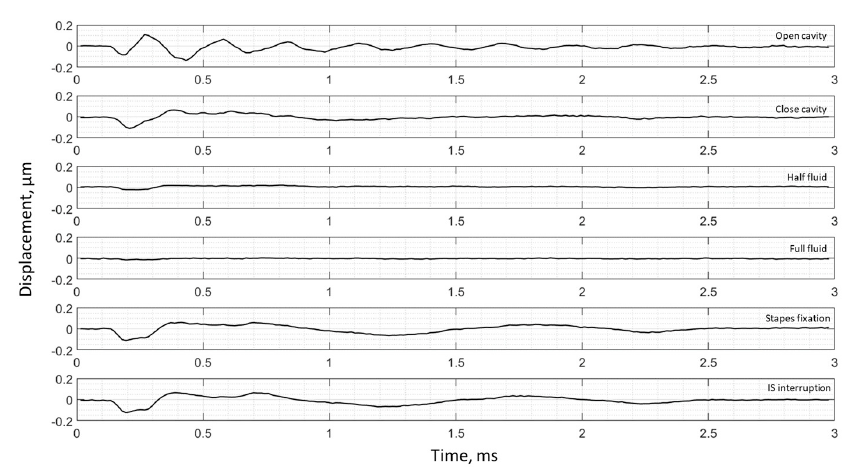
Figure 7. Umbo displacement of TB3 under different cases (umbo location is marked as the intersection of the solid black and dashed black lines in Figure 3a).